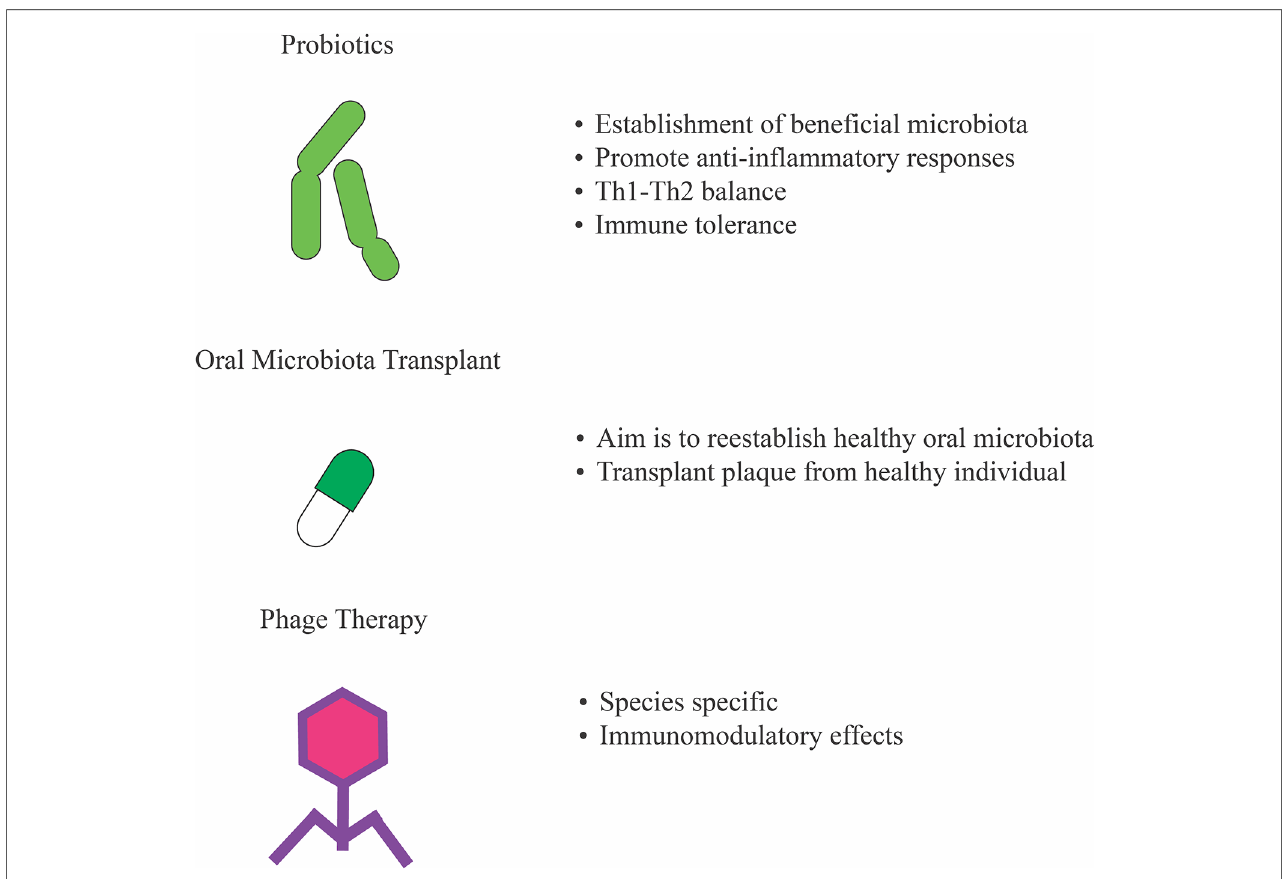
FIGURE 4 Potential therapeutics to treat oral dysbiosis. Suggested treatments to manage oral microbial dysbiosis to ameliorate diseases and allergies since alterations in microbiota composition is associated with immune sensitization and in fl ammatory